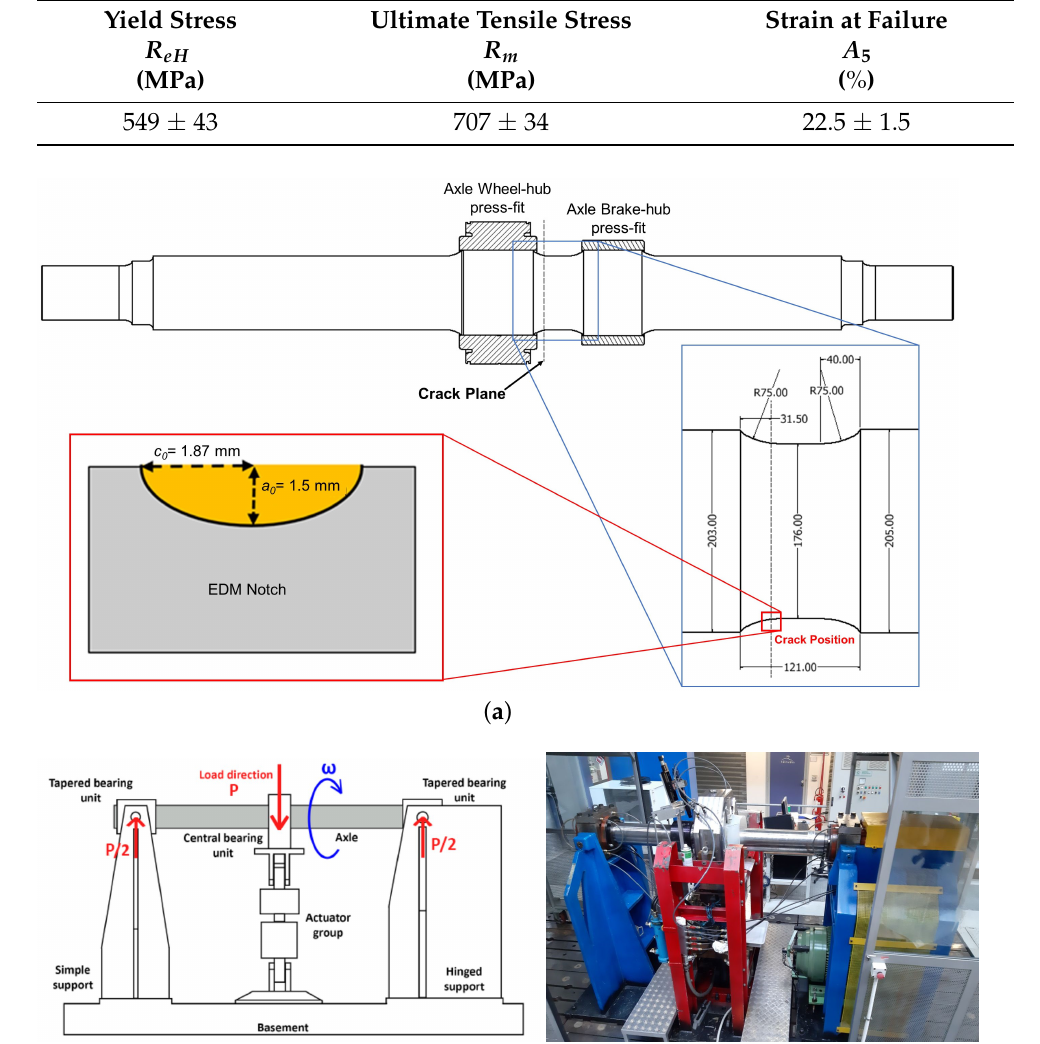
Table 1. Tensile properties for the EA4T steel investigated in the present study (according to EN13261).